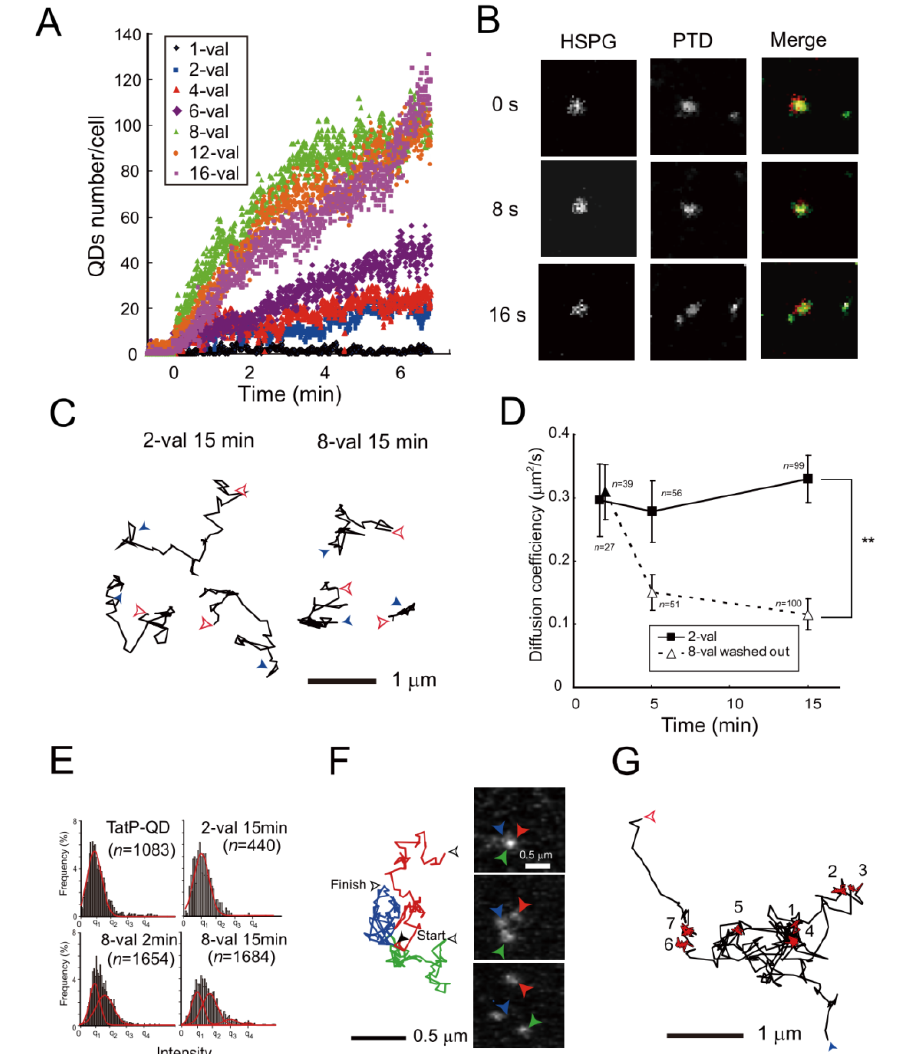
Figure 3. Single TatP-QD tracking on HeLa cells. ( A ) Typical time course of cell binding for TatP-QD, with different valences, to HeLa cells. The cells were exposed to TatP-QDs of the indicated valence or medium, and the images were collected at 400 ms/frame; ( B ) Time course fluorescence images obtained using a dual imaging system at 200 ms/frame. Fluorescence images of TatP-QD525 (lower left panel) and HSPG as detected by F58-10E4 plus secondary Ab labeled with QD705 (lower right panel) at 20 min of TatP exposure; ( C ) Typical trajectories of 2- or 8-val TatP after 15 min of exposure, recorded at 23 ms/frame; ( D ) Mean diffusion coefficient of 2- or 8-val TatP, over time up to 15 min, averaged for all particles in time window 1150 ms; ( E ) Intensity histogram of TatP-QDs at the indicated time and condition, fitted to four Gaussian curves. The mean of the first peak is equal to TatP-QD (left upper panel), defined as q1; ( F ) Selected frames (left) and trajectories of 8-val TatP-QDs from 23 ms/frame after a 15-min exposure. Arrowhead color corresponds to that of its trajectory; ( G ) 8-val TatP often exhibited alternating periods of apparently simple Brownian diffusion (black) and temporary immobilization (red). ** P < 1 × 10 − 7 Reproduced with permission from reference 32. Permission is required from copyright